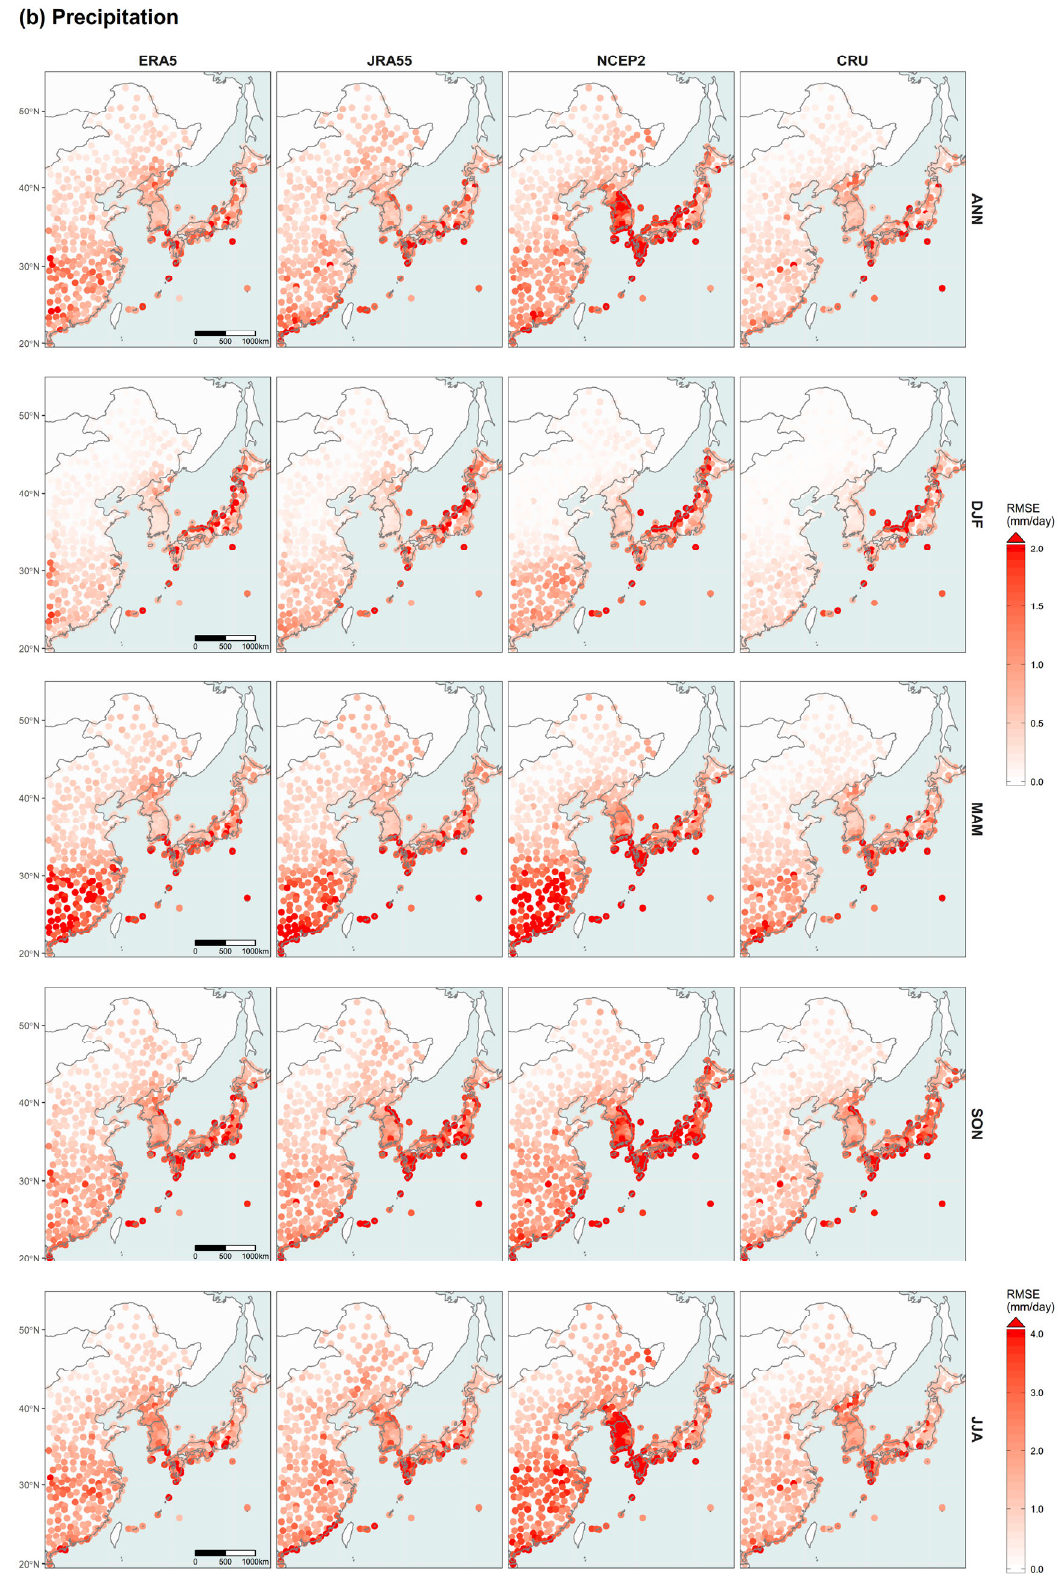
Figure 5. Same as in Figure 4, but with root ‐ mean ‐ square error (RMSE) of ( a ) temperature and ( b ) precipitation. The scale of precipitation in JJA ( b ) is different from that of other seasons.